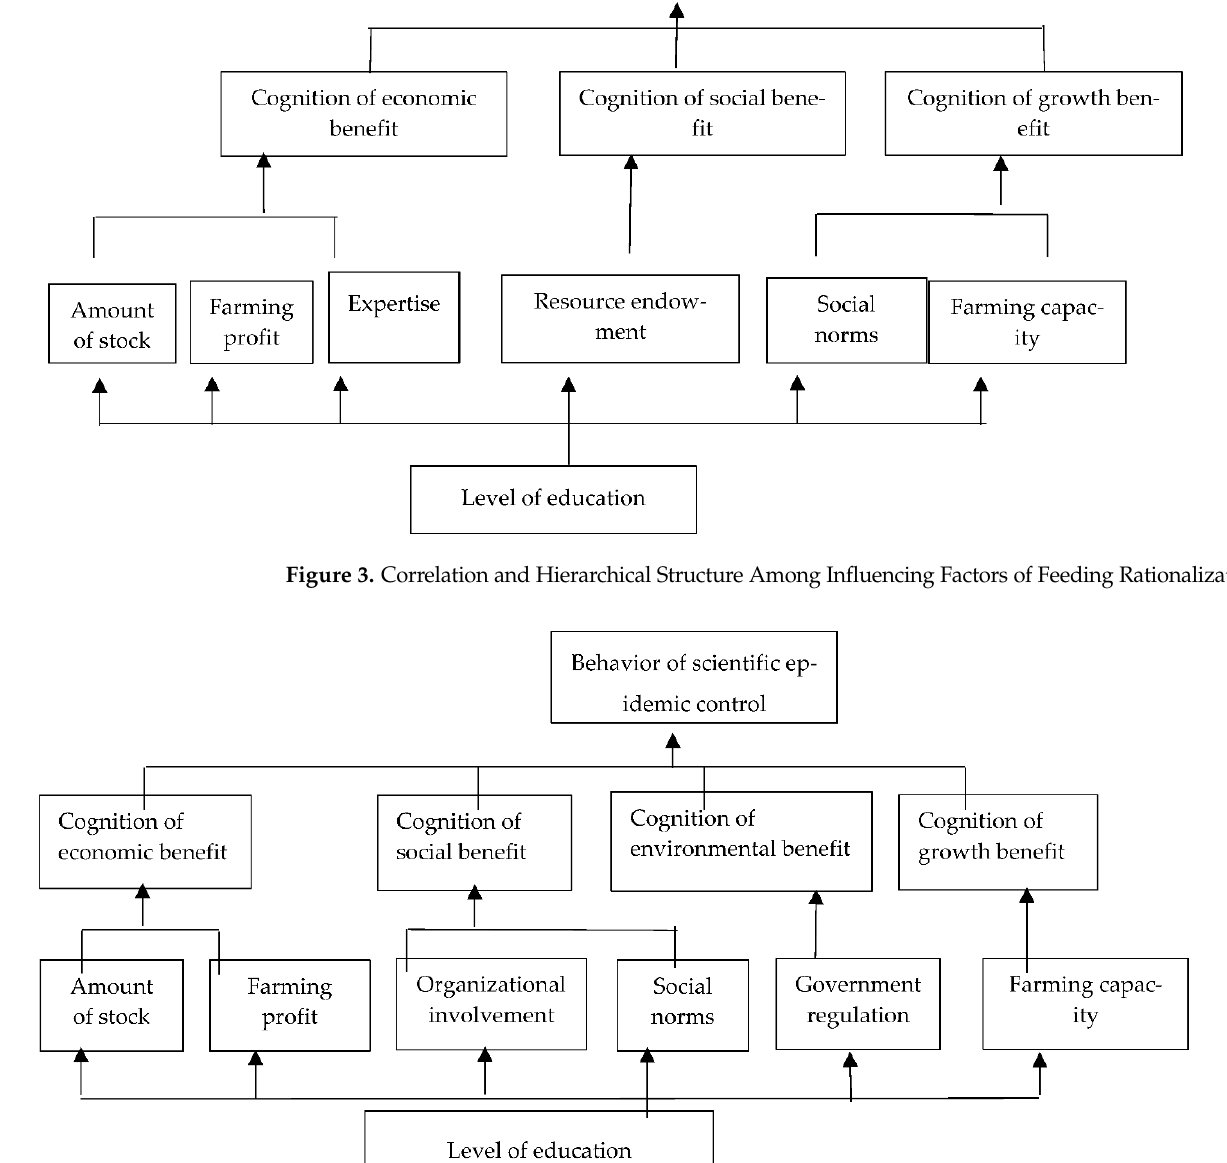
Figure 5. Correlation and Hierarchical Structure Among Influencing Factors of Standardized Man ‐ agement.